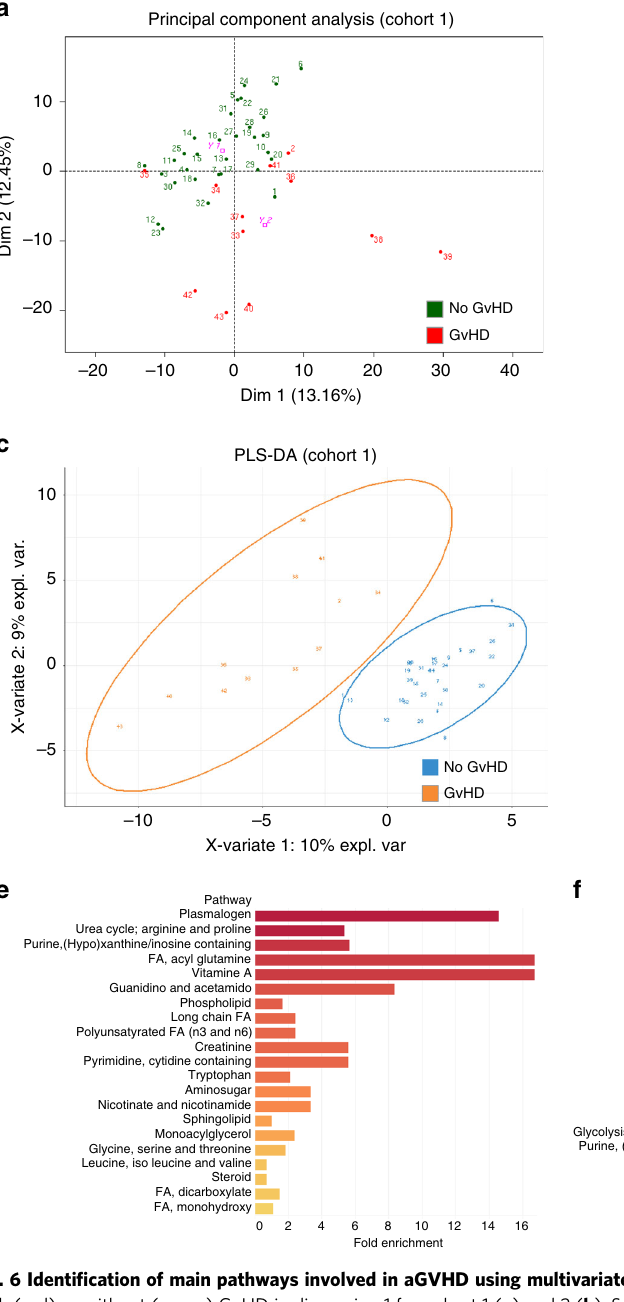
analysis of Ra vs paired Rs, given matching was performed on age and sex, estimates were only adjusted for difference in BMI between the two subjects of a pair. All analyses were performed using R and appropriate additional packages, as described below.